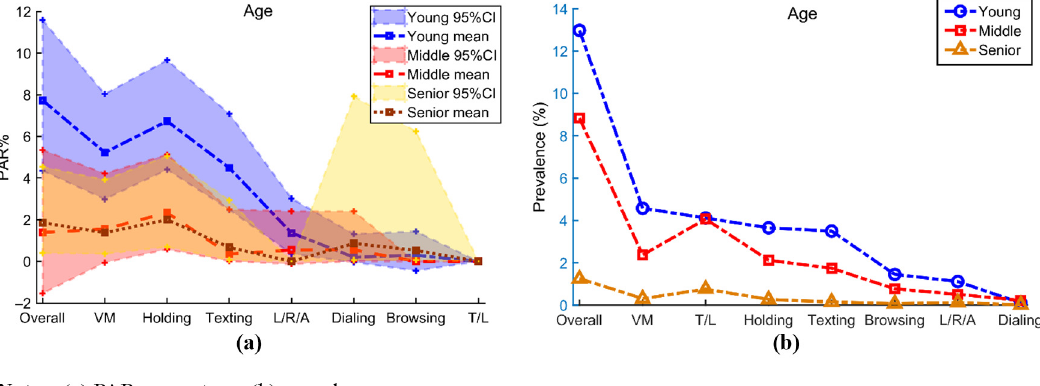
Figure 1 PAR percentage and prevalence analysis results of the